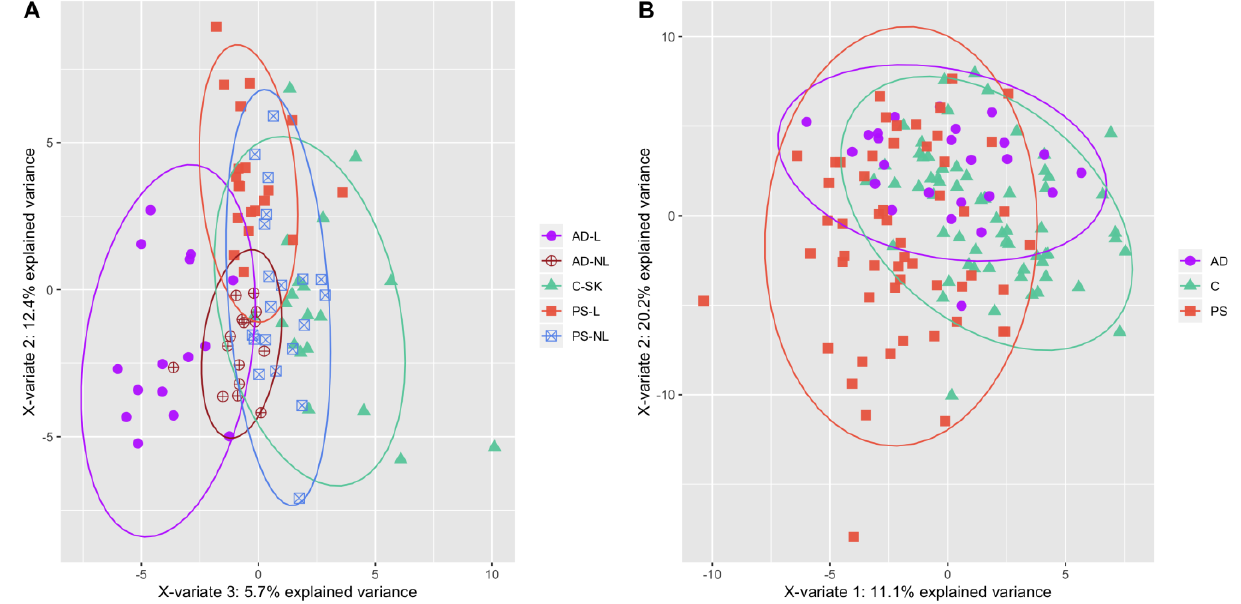
Figure 1. ( A ) PLS-DA plot of the samples of AD (lesional skin — filled violet circles, non-lesional skin — empty violet circles), PS (lesional skin — filled red squares, non-lesional skin — empty blue squares) and C (filled green triangles) skin. ( B ) PLS-DA plot of the samples of AD (violet circles), PS (red squares) and C (green triangles) sera. Data is based on metabolites that changed statistically significantly from Kruskal – Wallis test. Table 1. Targeted analysis results from Mann–Whitney–Wilcoxon (MWW) test where AD patients’ lesional skin samples were compared to PS patients’ lesional skin